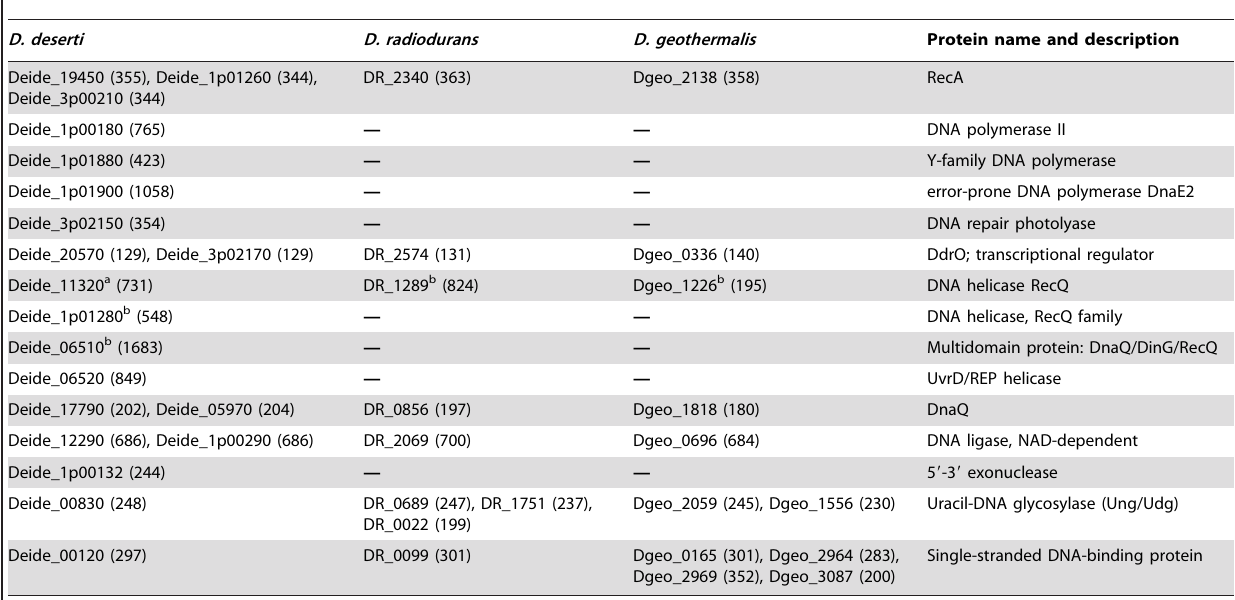
Polypeptide lengths are indicated between parentheses. a Two HRDC domains were found in Deide_11320, three in DR_1289, and one in Dgeo_1226.